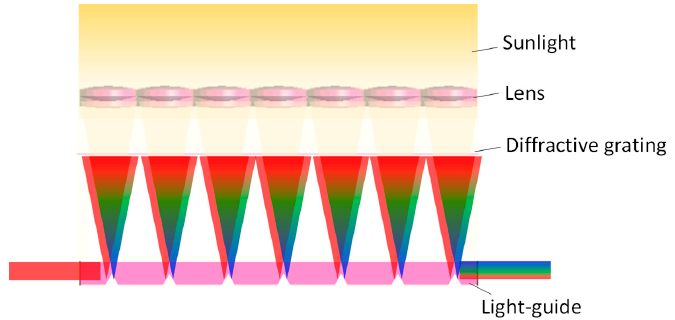
Figure 1. Schematic of the side-absorption concentrated module for spectral-beam splitting.